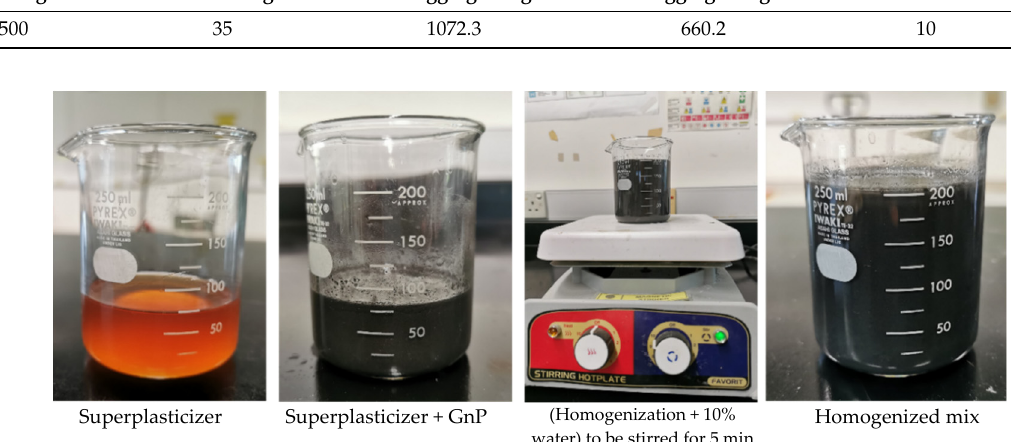
Figure 4. Descriptive method of the dispersion process of GnP.